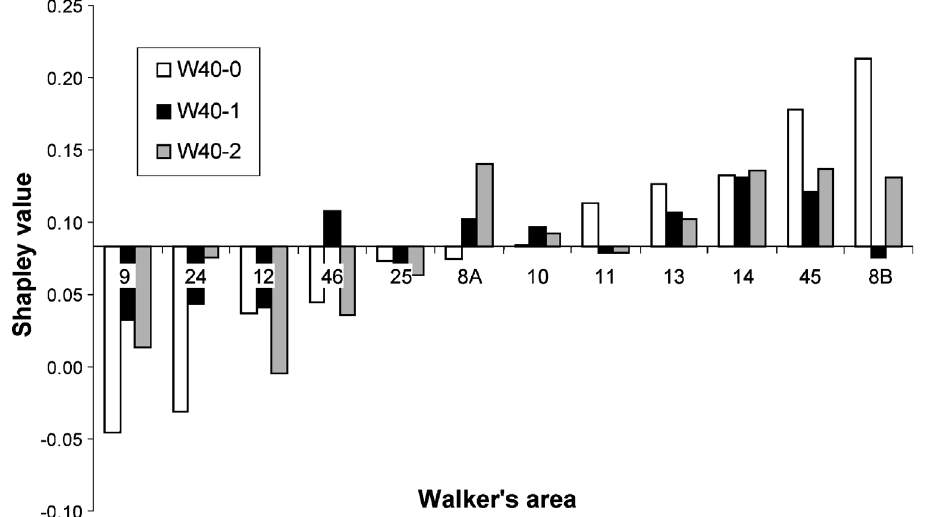
Figure 4. Histograms showing the relative Shapley ratings for areas in the three variants of the W40 network, sorted by scores for the W40-0 variant. The x-axis is located at the expected Shapley value for a 12-node network, which is 1/12 (cid:5)